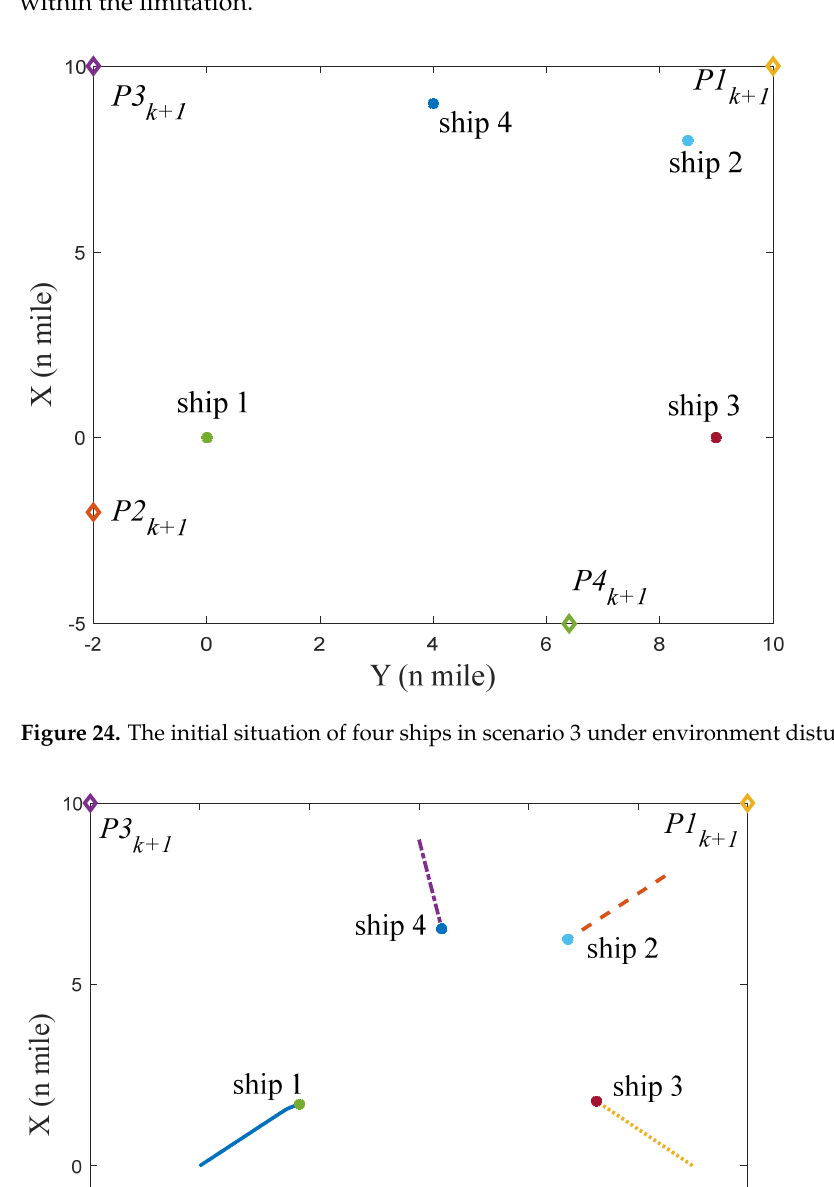
Figure 24 indicates the initial situation of four ships in scenario 3; Figures 25–27 denote the situation of four ships in scenario 3 at 600 s, 2400 s, and 3200 s separately; Figure 28 denotes the distance between ship–1 and other ships; and Figure 29 indicates the course and rudder angle of ship–1. As we can see in Figures 24–28, the distance between ship–1 and other ships is more than 1 mile, which means that the collision avoidance between ship–1 and other ships can be achieved, and after collision avoidance, ship–1 can navigate to the destination. From Figure 29, it can be concluded that the rudder angle of ship–1 is within the limitation.